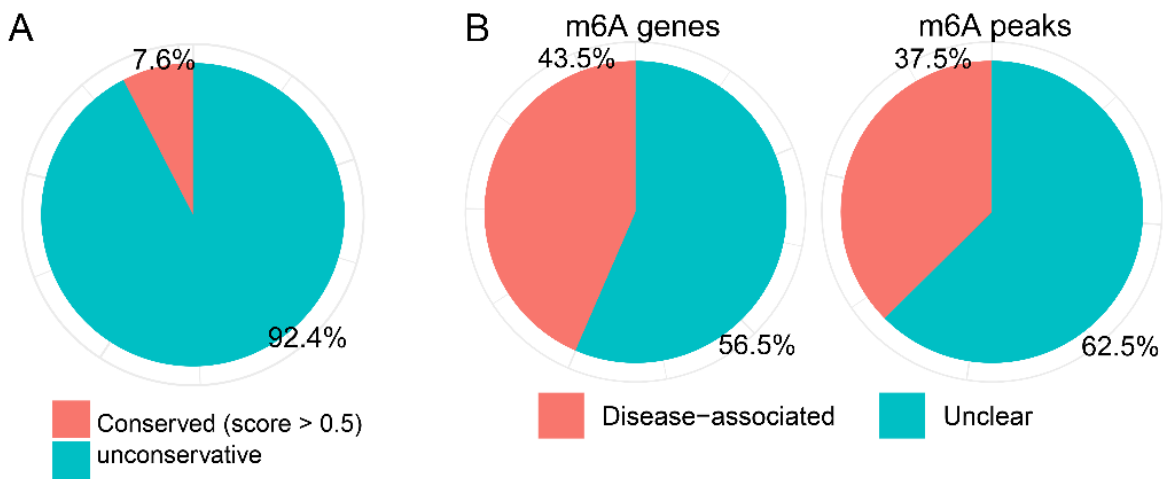
Figure 5. The ( A ) conservation of m6A sites and ( B ) disease association of the 2289 overlapping genes. After the AFB1 treatment in HCT116 cells, the mRNA expression levels related to cell cycle ( MYC , CCNB1 , CDC25C , ATM , and CHEK2 ), protein processing in ER ( PDIA3 , HSPA5 , (Table 1). The m6A regulators were identified using the CLIP technique, including several writers and readers. Table 1. The mRNA expression and their potential substrates of m6A